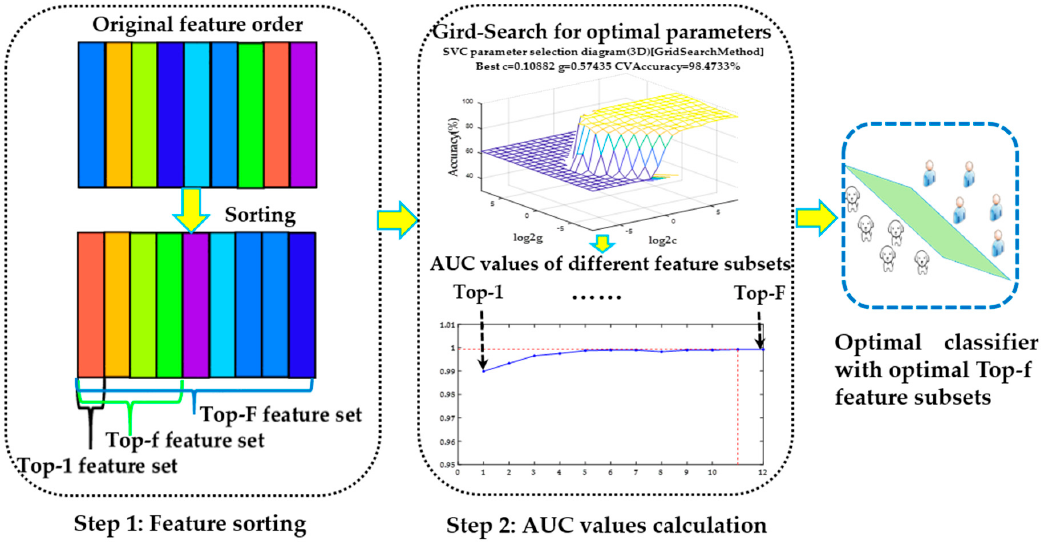
Figure 9. Detailed processes of the SVM-RFE. In “ Step 1 : Feature sorting”, the color of a feature represents its contribution in the distinguishing task. A warmer color denotes more contributions.